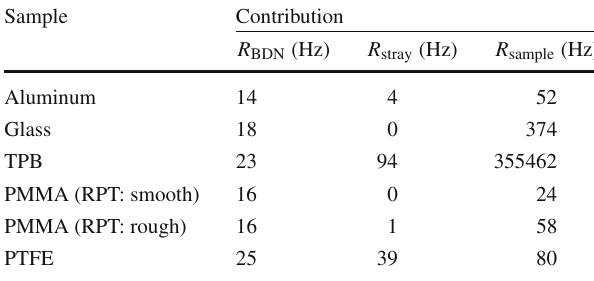
Table 1 Background and signal rates observed with the PMT for sam- ples measured with 160nm excitation light at 39.5 ◦ incidence angle. R stray , and the sample rates of aluminum and glass are used to estimate the background light level in the signal observed from the plastic